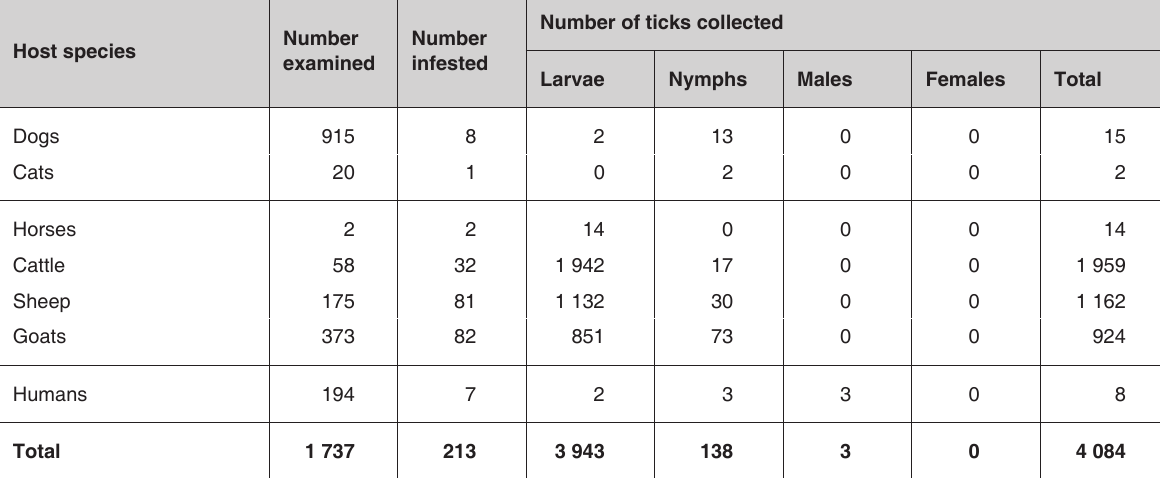
TABLE 6 Amblyomma marmoreum collected from domestic animals and from humans